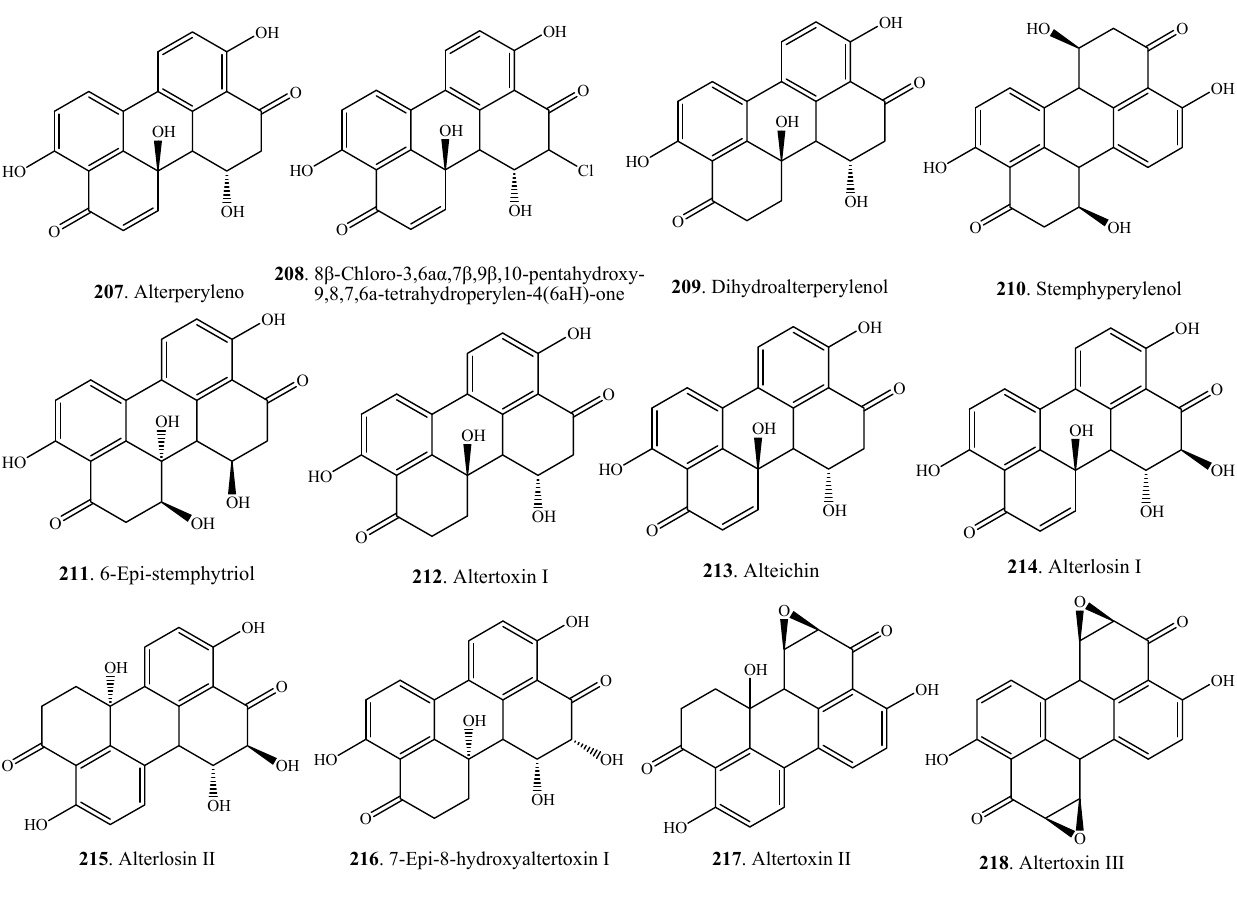
Figure 11. Perylenequinone derivatives isolated from Alternaria